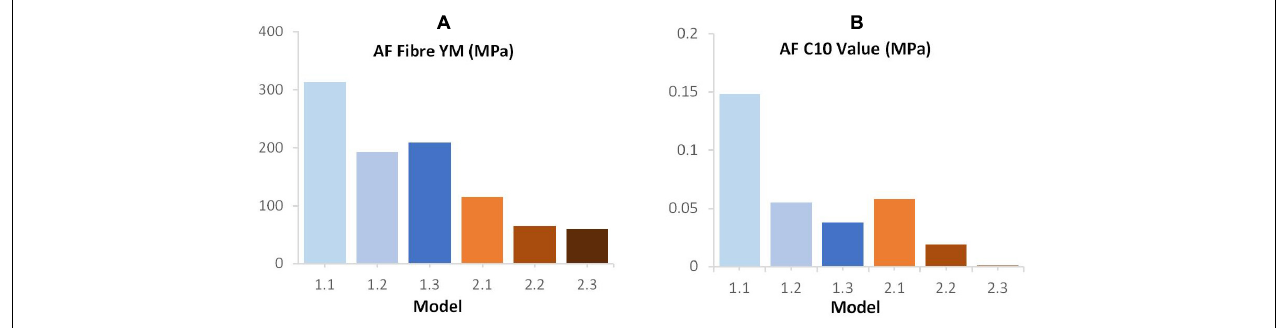
FIGURE 8 | Final (A) AF fibre YM (B) C 10 values following optimisation of these parameters in order to achieve a good fit between the computational and experimental data reported by Newell et al. (2017).